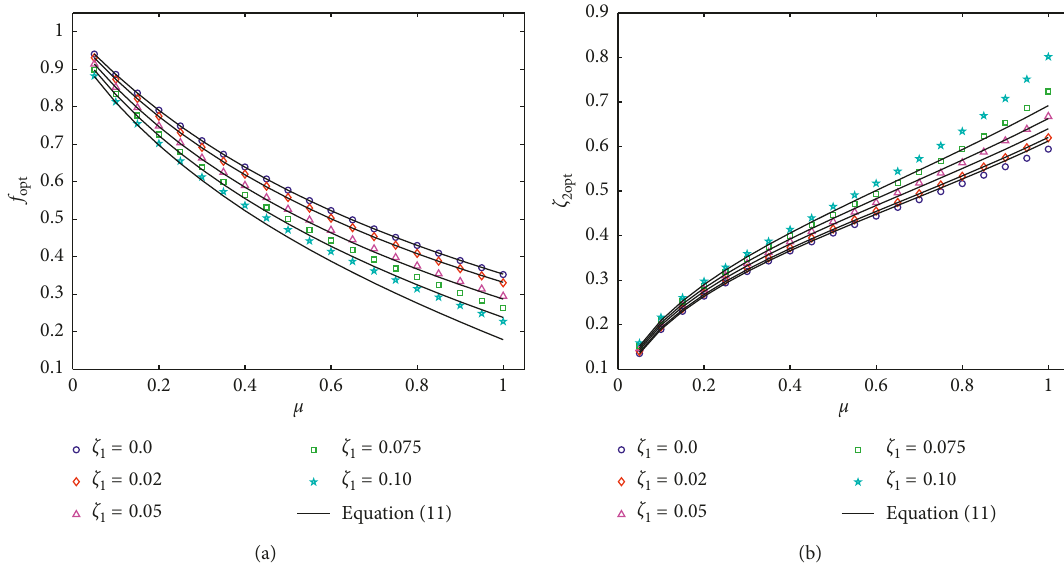
Figure 3: The curve of the calculated value of the existing fitting formula and the actual optimal value varies with the mass ratio under the excitation of harmonic load. (a) Contrast results of the frequency ratio. (b) Contrast results of the damping